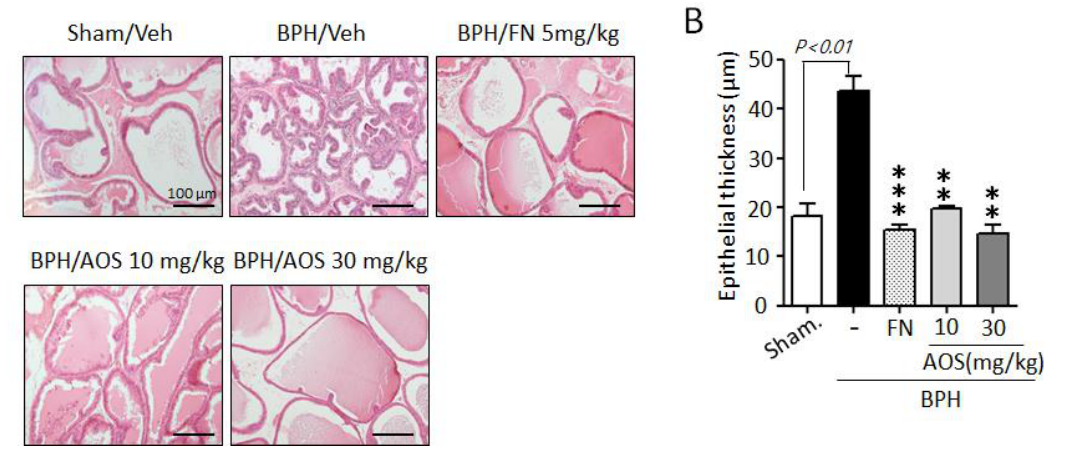
Figure 4. Histopathological analysis of the prostate tissues collected from rats with testosterone propionate (TP)-induced benign prostate hyperplasia (BPH). ( A ) Representative histological images using hematoxylin and eosin (H&E) staining (microscope magnification, × 100). Scale bar, 100 µ m. ( B ) Quantification of the thickness of epithelial layers by ImageJ software. The graph represents mean ± standard deviation ( n = 3 per group); ** p < 0.01, and *** p < 0.001 compared with the BPH/Veh group. Legend: Sham/Veh, the sham-operated group used as a negative control; BPH/Veh, castrated rats receiving TP + vehicle; BPH/FN, castrated rats receiving TP + finasteride; BPH/AOS, castrated rats receiving TP + different concentrations of AOS.